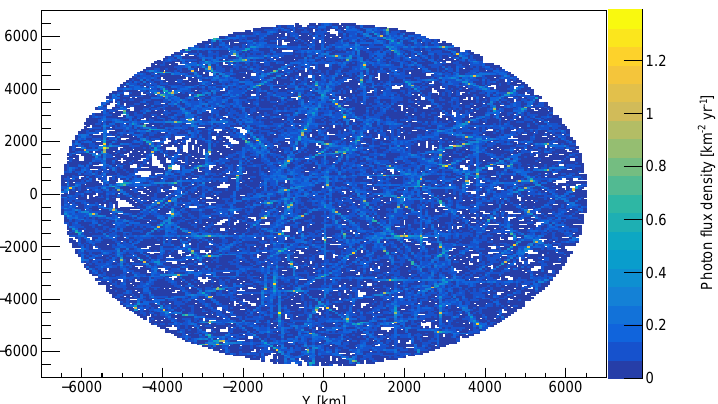
Figure 8. The cumulative spatial distribution of secondary photons at the top of the atmosphere, for the primary photon energy 100 EeV, based on 324 observable secondary photon cascades, which corresponds to one year of